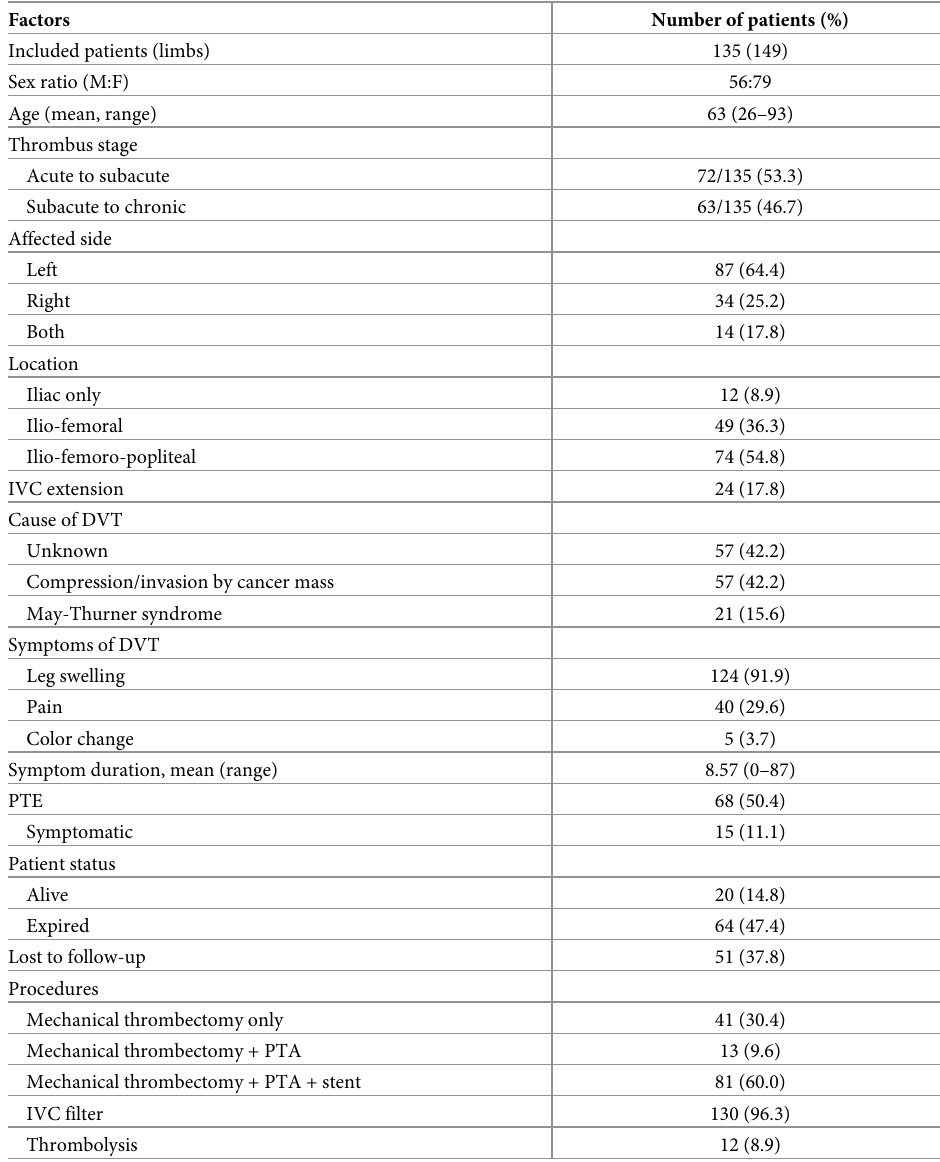
Table 1. Patient